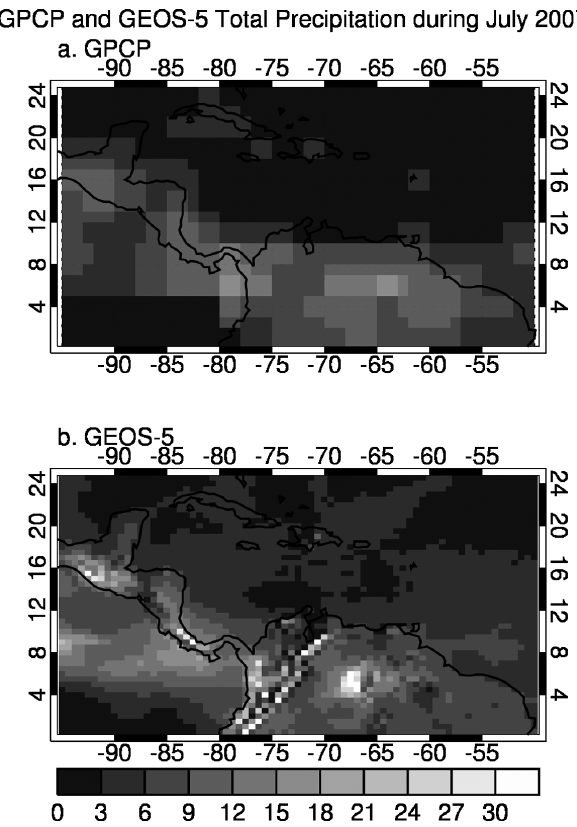
Fig. 7. July 2007 monthly mean GPCP (a) and GEOS-5 (b) total precipitation (mmday − 1